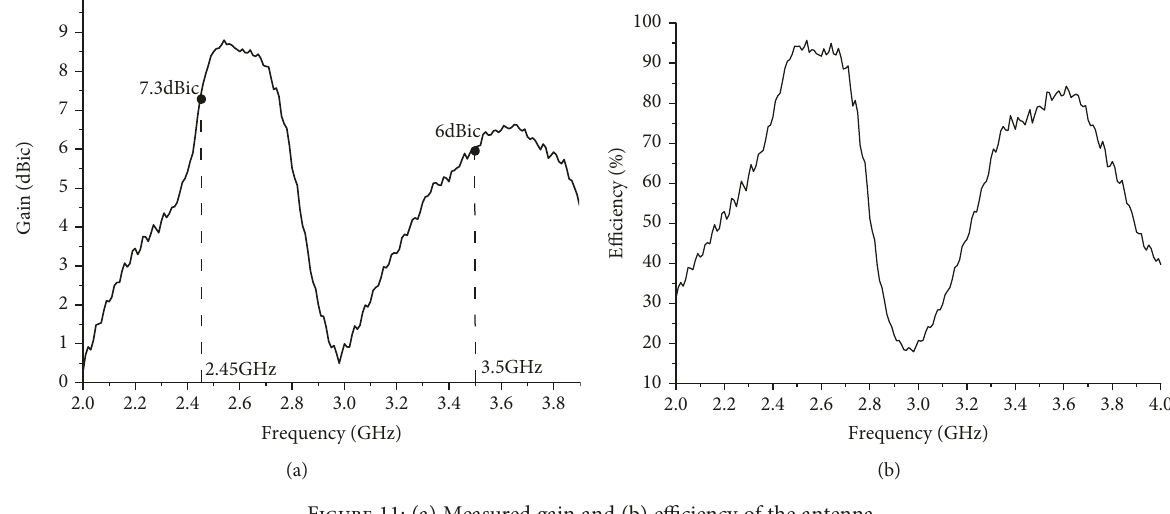
Figure 11: (a) Measured gain and (b) e ffi ciency of the antenna.